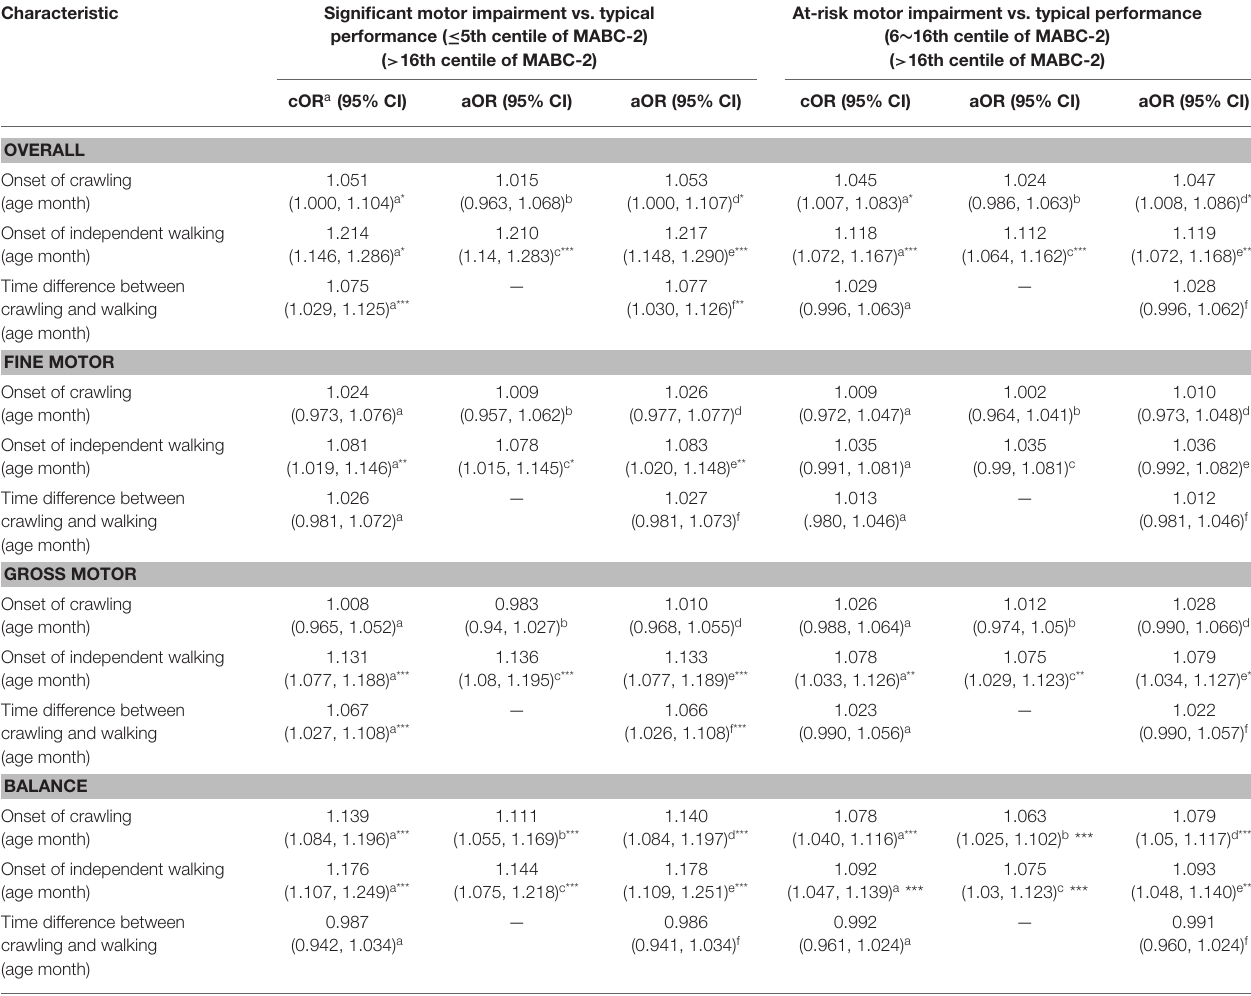
TABLE 2 | Effects of timing crawling and walking during infancy on motor impairments ( n = 8,395).